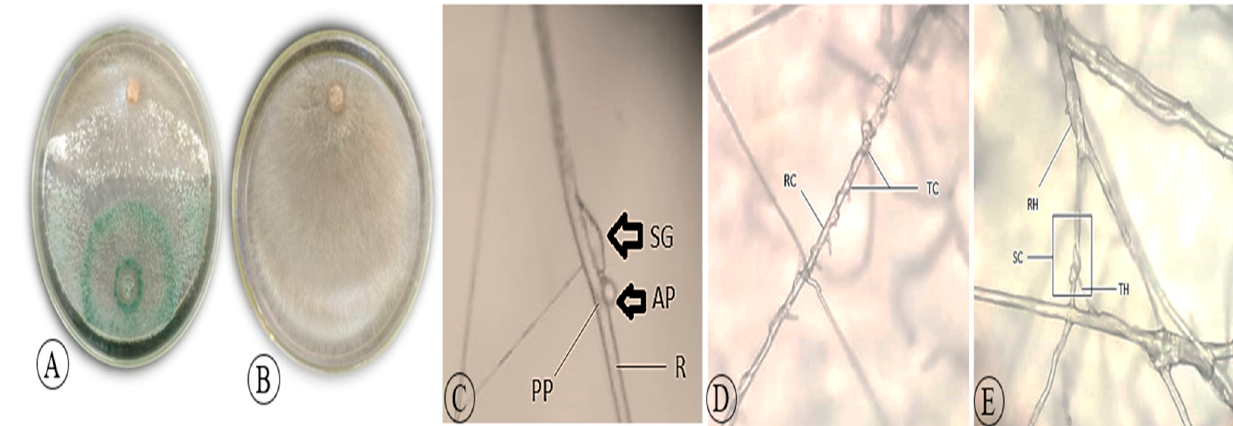
Figure 3. Trichoderma asperelloides Ta41 hyphae mycoparasitism on R. solani Rs33 (R) using a dual culture technique. ( A ) T. asperelloides Ta41 and R. solani Rs33 confronting each other; ( B ) R. solani Rs33 control; ( C ) 10X light microscope graphs of Ta41 penetrating the Rs33 (R) cell wall as a result of spore germination (SG), the formation of appressorium (AP), and the penetration peg (PP) (semi-visible); ( D ) Ta41 starting to coil (TC) around the Rs33 cell wall (RC); ( E ) Ta41 hyphae (TH) densely coiling and encircling the Rs33 hyphae as a supercoil (SC); the arrow (RH) points to the Ta41 thin hyphae in the